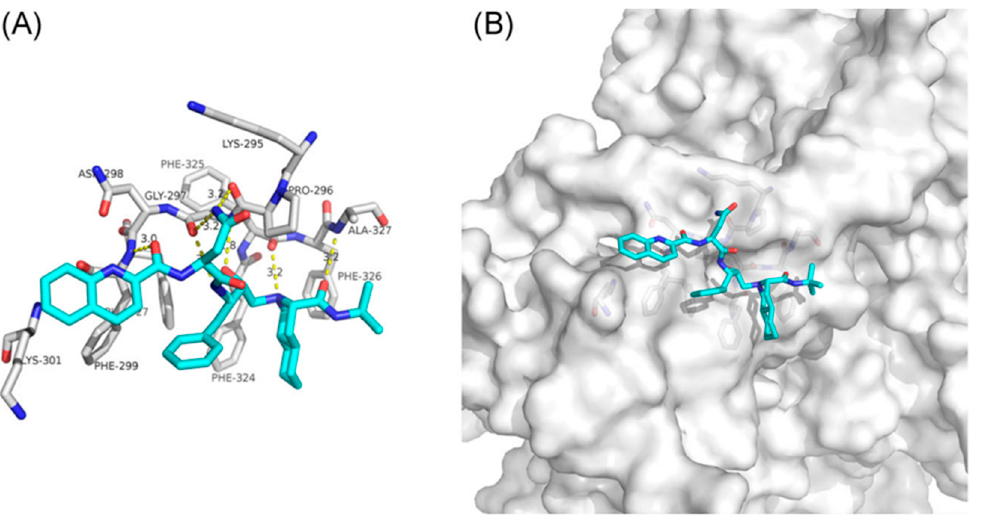
Figure 5. Proposed model of inhibition of SARS-CoV NSP12–NSP7 by saquinavir (PDB ID 6NUR). ( A ) Saquinavir interaction with the interface of the crystal structure of NSP12–NSP7; ( B ) saquinavir binding in the protein interface pocket between NSP12 and NSP7. Adapted from [29] .